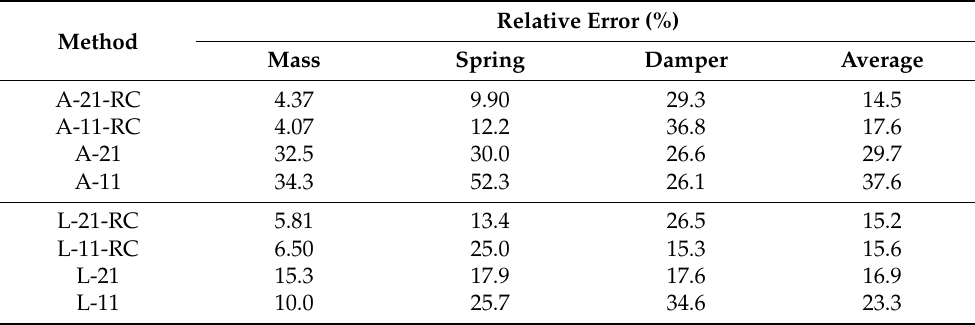
Table 2. The relative error between real model parameter and predicted model parameter from the first neural network for model identification after training 10 million